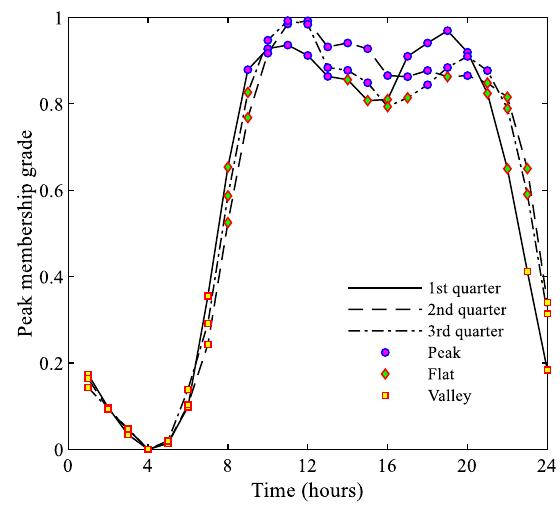
Fig. 2 Peak membership of each time